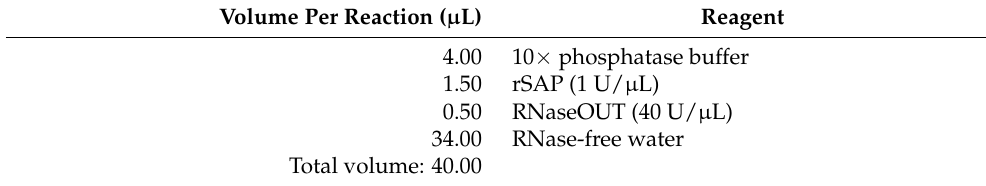
Table 3. 1 × Phosphatase Reaction Mix. Prepare RNA–primer mix (Table 7):